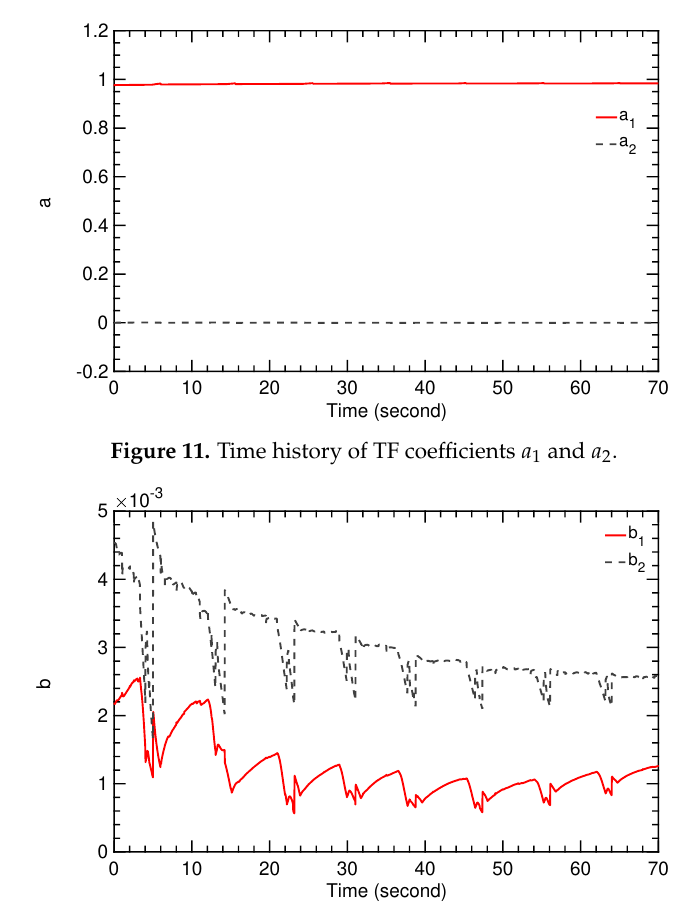
Figure 12. Time history of TF coefficients b 1 and b 2 .